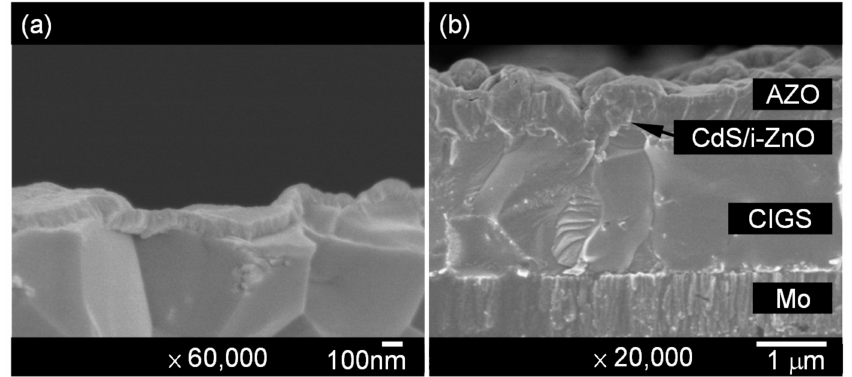
Figure 3. ( a ) SEM cross-sectional view of CBD CdS buffer layer on a CIGS film, and ( b ) SEM cross-sectional view of a CIGS solar cell prepared by the two-step